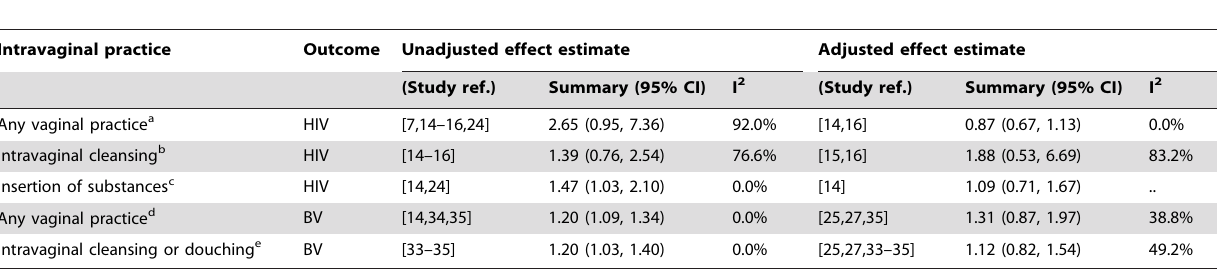
Table 2. Summary effect estimates for studies reporting associations between intravaginal practices and HIV-1 (objective 1), and intravaginal practices and vaginal infections (objective